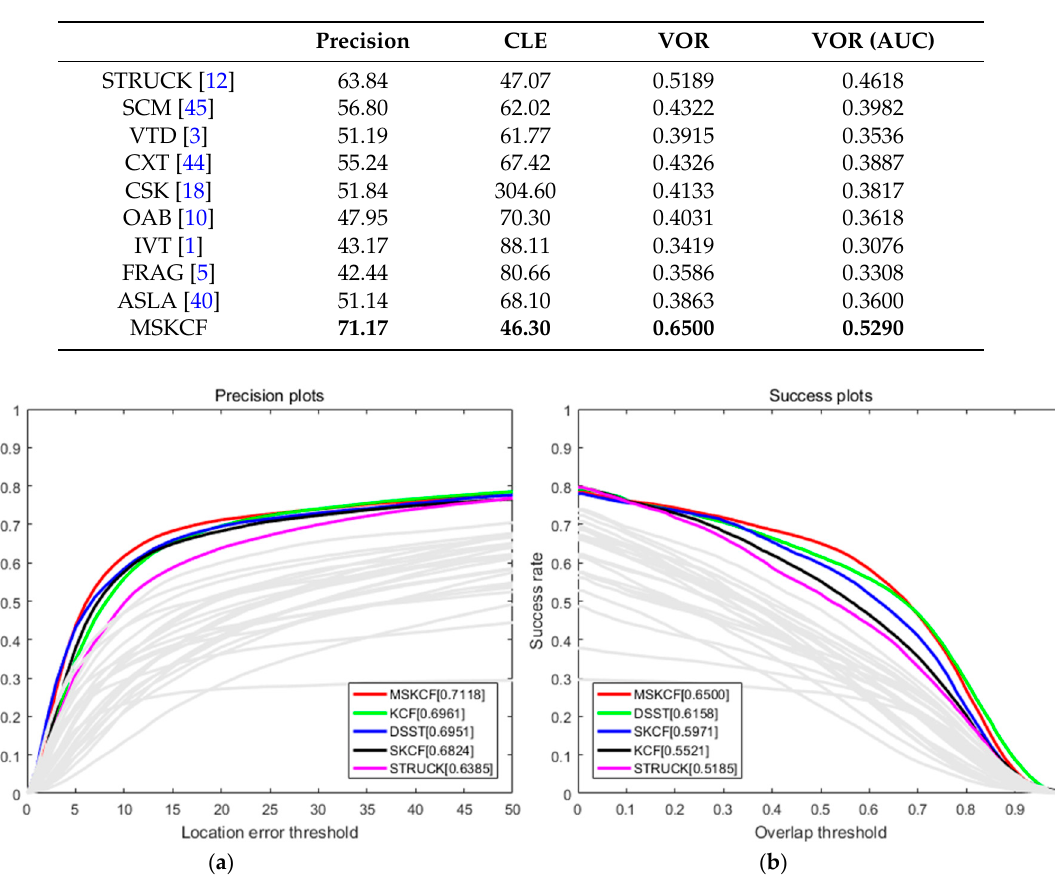
Figure 5. Precision ( a ) and success ( b ) plots over all 100 sequences using one pass evaluation for correlation filter-based trackers [14,15,17,18]. Table 2. Quantitative comparison of our tracker with OTB trackers over all 100 challenging dataset. The high score indicates the best performance among the algorithms.